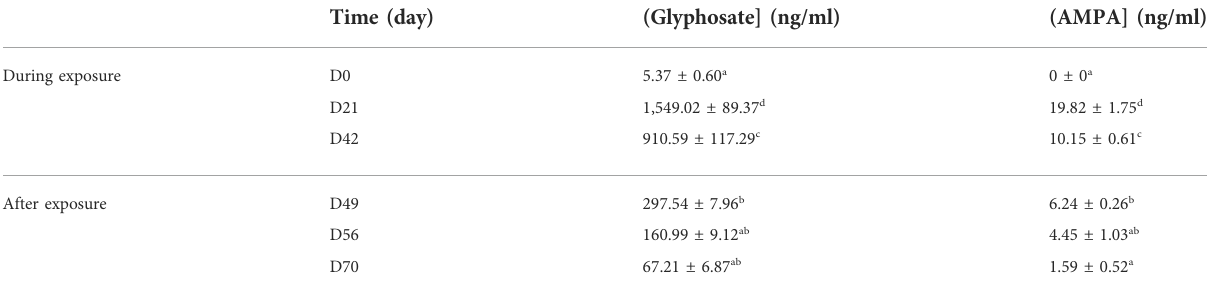
TABLE 3 Glyphosate and AMPA concentrations in hen ’ s plasma during (n = 10) and after (n = 10) the dietary GBH exposure period.